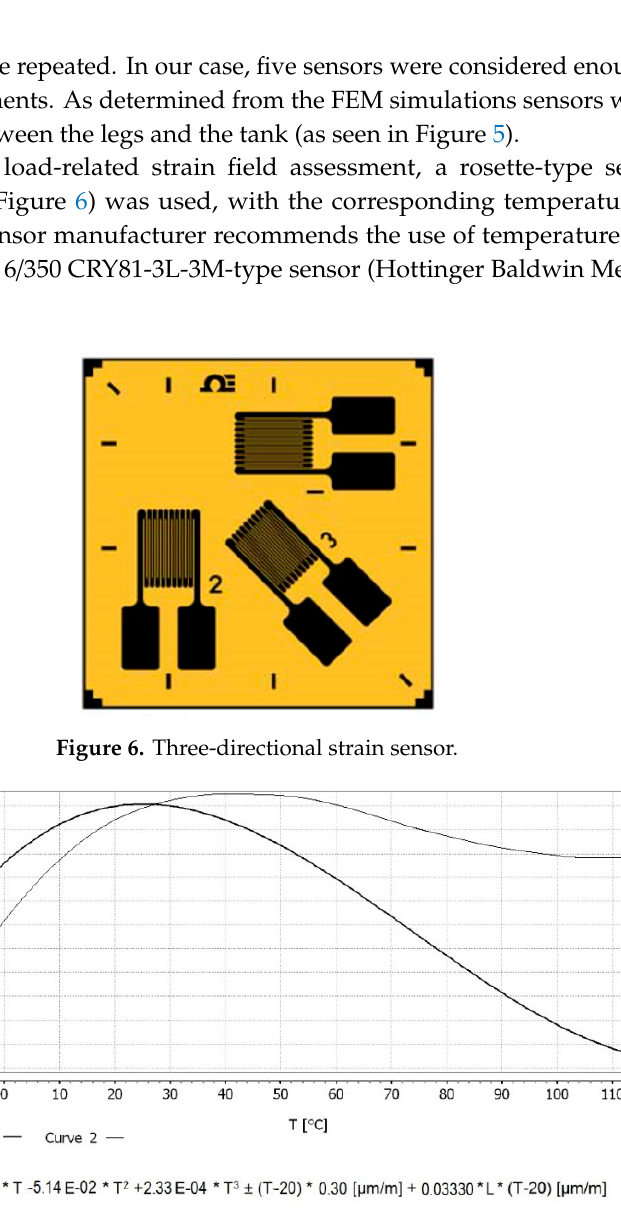
Figure 7. Three-directional strain sensor characteristics.